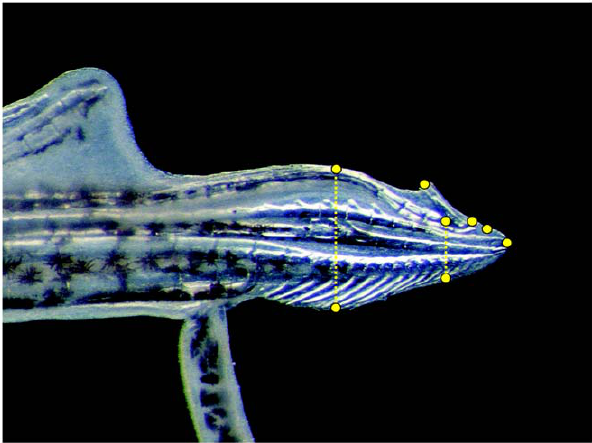
Figure 1. Photograph of the distal tip of the gonopodium of Poeciliareticulata in lateral view. Eight landmarks (yellow dots) were superimposed on each image using geometric morphometric software (see text for